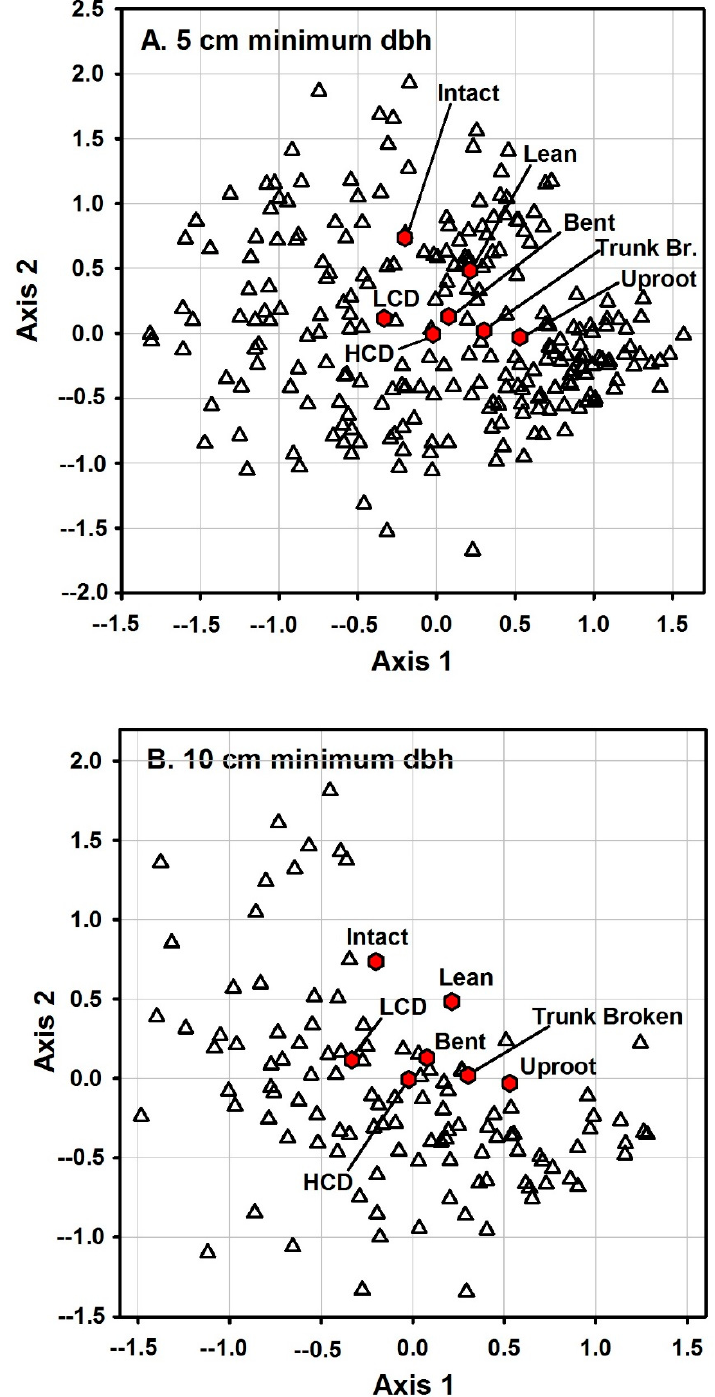
Figure 7. Nonmetric Multidimensional Scaling ordination of plots based on damage type categories. ( A ) 5-cm minimum diameter, n = 237 plots; ( B ) 10-cm minimum diameter, n = 111 plots. LCD = Light crown damage; HCD = Heavy crown damage.